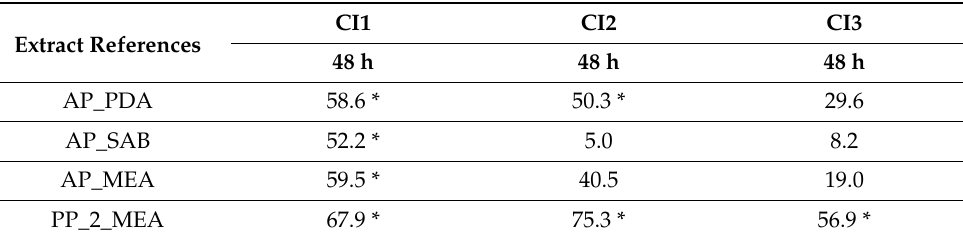
Table 3. Anti-biofilm activity of endolichenic fungal extracts at 100 µ g/mL on biofilms formed by clinical isolates (CI) of C. albicans . Extracts were added to 24 h-old biofilms. The contact duration between extracts and biofilms was 48 h.